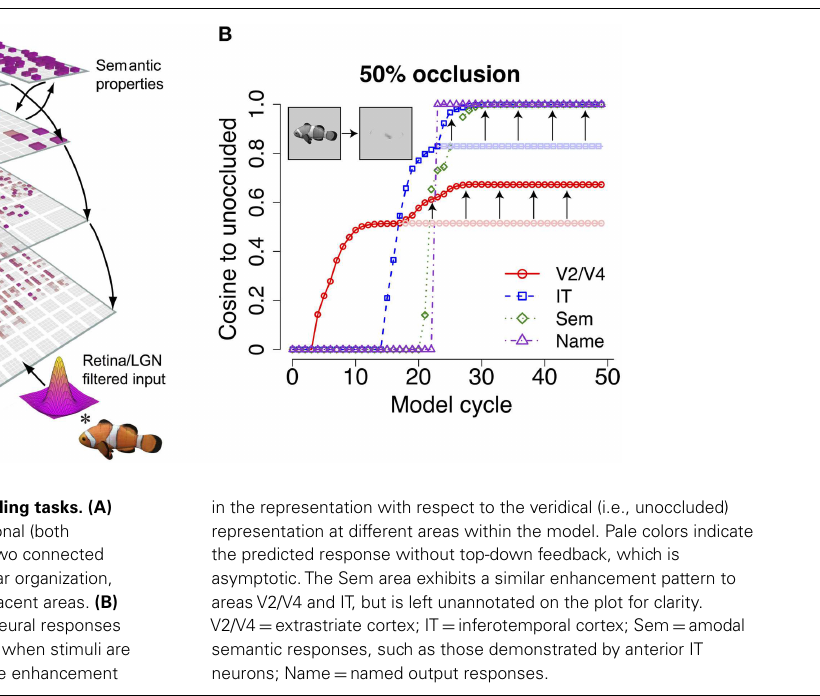
FIGURE 2 |Top-down feedback in “hardwired” binding tasks. (A) As a general rule, the visual system contains bidirectional (both bottom-up and top-down) connections between any two connected areas.The LVis model, depicted here, contains a similar organization, with recurrent connections between hierarchically adjacent areas. (B) Top-down feedback from higher levels enhances the neural responses in lower-level areas, which is crucial for robust binding when stimuli are occluded or otherwise ambiguous. Arrows indicate the enhancement